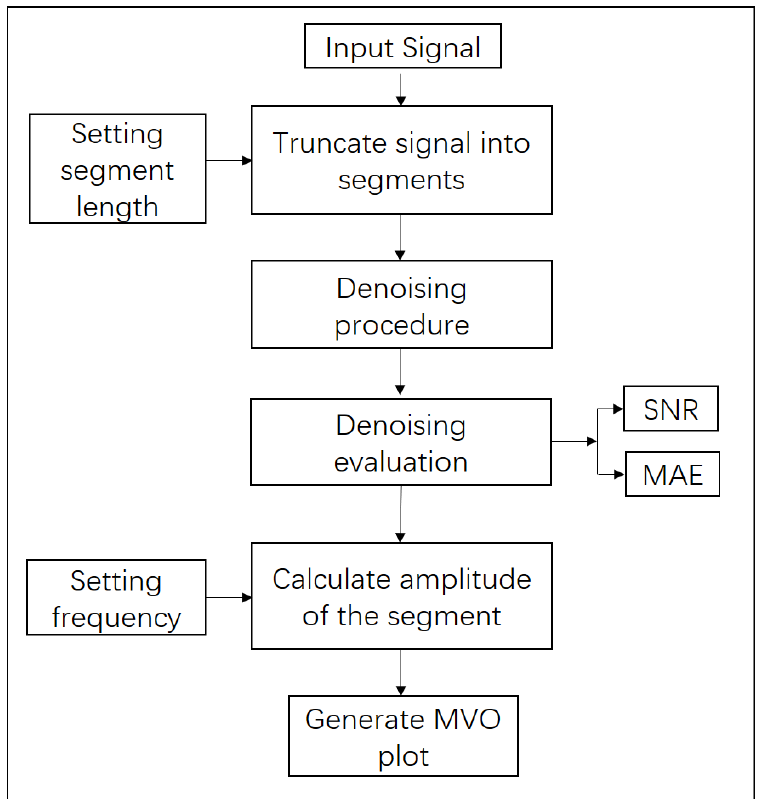
Figure 4. Flow chart of the denoising technique described in this article. There are three inputs including the target signal, the setting window length and frequency. Note that the denoising processing and evaluation procedure are defined for time series, and the denoising effect is illustrated through MVO plots at given